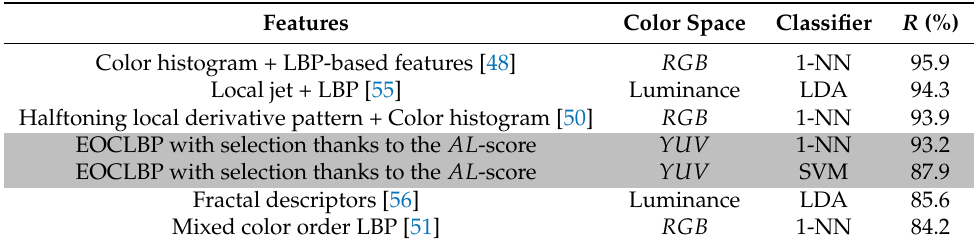
Table 7. Comparison between the classification accuracies reached with the USPTex set.